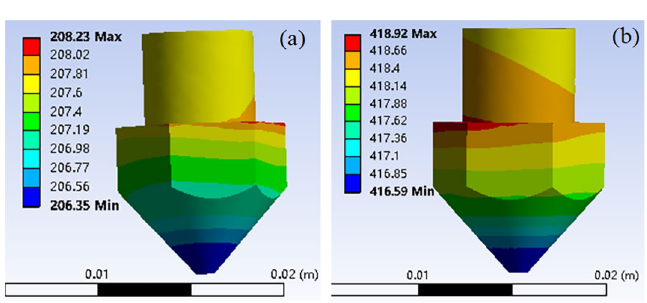
Figure 4. Temperature distribution of nozzle: ( a ) lower system and ( b ) higher